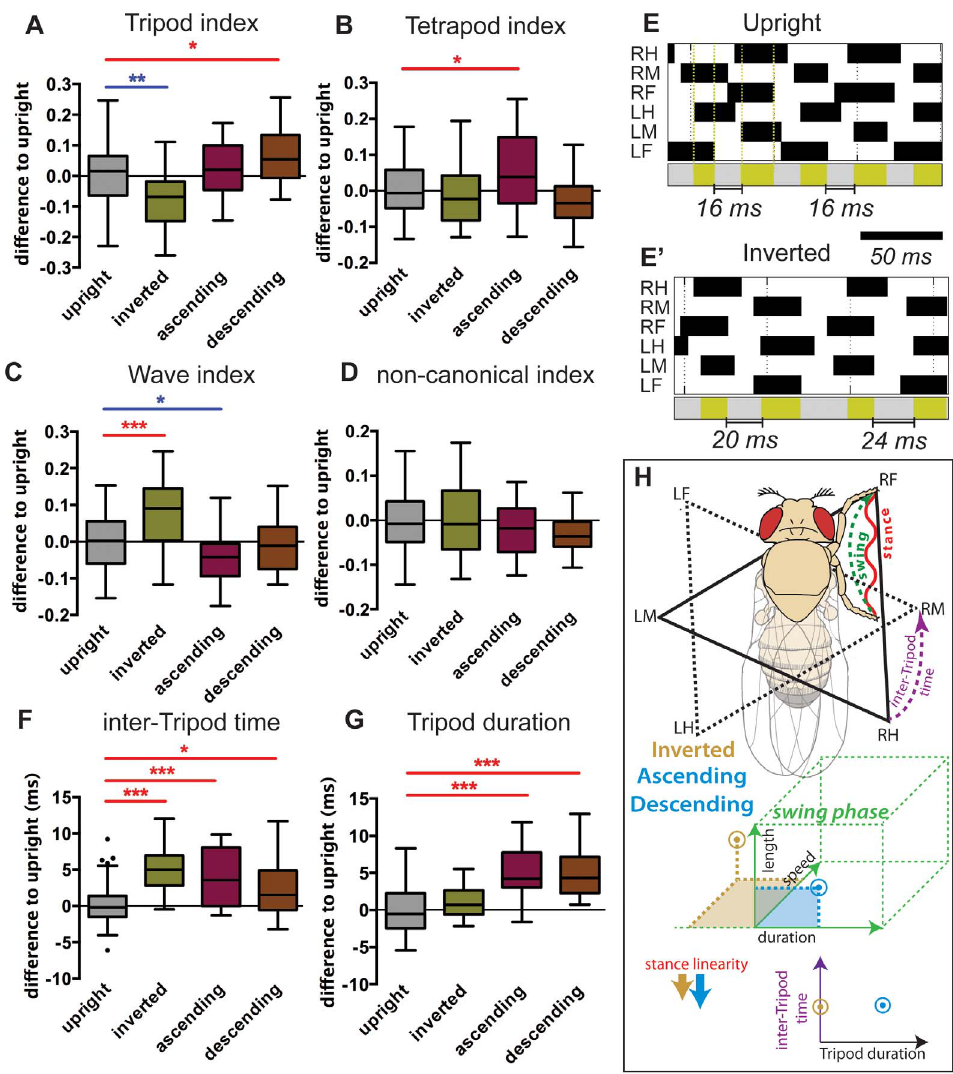
Figure 3. Interleg coordination parameters and summary of kinematic effects in non-upright walking animals. (A–D, F–G) Boxplots represent the median as the middle line, with the lower and upper edges of the boxes representing the 25% and 75% quartiles, respectively; the whiskers represent the range of the full data set, excluding outliers. Circles indicate outliers. Data was residual normalized and expressed as the difference to the upright control. Statistical analysis with one-way ANOVA followed by Tukey’s post hoc test, * P , 0.05; ** P , 0.01; *** P , 0.001. Statistically significant increases or decreases are indicated in red and blue, respectively. (A) Inverted walking animals display a significant decrease in tripod configurations while descending animals showed an increase. (B) Only ascending animals displayed a slight increase in tetrapod configurations. (C) Inverted walking animals display a significant increase in the use of wave conformations while ascending animals showed a slight decrease. (D) No variation was observed in the number of non-canonical combinations for all experimental groups. (E) Step patterns and tripod/ transition phases. (E) and (E’) display two representative videos of animals walking upright and inverted at similar speeds, respectively. In the upper section, for each leg, swing phases are represented in black (from top to bottom: right hind (RH); right middle (RM); right front (RF); left hind (LH); left middle (LM); left front (LF)). Vertical dashed green lines represent the boundaries of a tripod stance phase. Lower section represents the periods associated with tripod and transition (or inter-Tripod time ) phases depicted in green and grey, respectively. (F) Non-upright walking animals display a significant increase in inter-Tripod time. (G) Animals walking in a vertical plane display an increase in the average duration of each tripod stance phase. (H) Summary of kinematic affects under non-upright conditions. For simplicity, only the step cycle of the right foreleg is represented. Dashed green line represents the swing phase from PEP to AEP. Waved red line represents stance traces. Solid triangle represents the tripod conformation formed by RF, LM and RH. Dashed triangle represents the immediately subsequent tripod conformation. Purple dashed line represent the inter- Tripod time between the two tripod conformations. Brown and blue arrows represent the qualitative variations compared to upright walking animals observed for inverted and ascending/descending, respectively. doi:10.1371/journal.pone.0109204.g003 transitioning between two complementary tripod stances; and times, with values of , 10 ms for fast animals compared to , 20 ms for slow animals (Figure S6A). In general, animals Tripod duration , which measures the average duration of each tripod stance (see methods section for details) (Figure 3E–G). walking under non-upright conditions had larger inter-tripod Interestingly, faster animals display reduced inter-tripod transition transition values (Figure 3E, F and S6A). In addition, Tripod